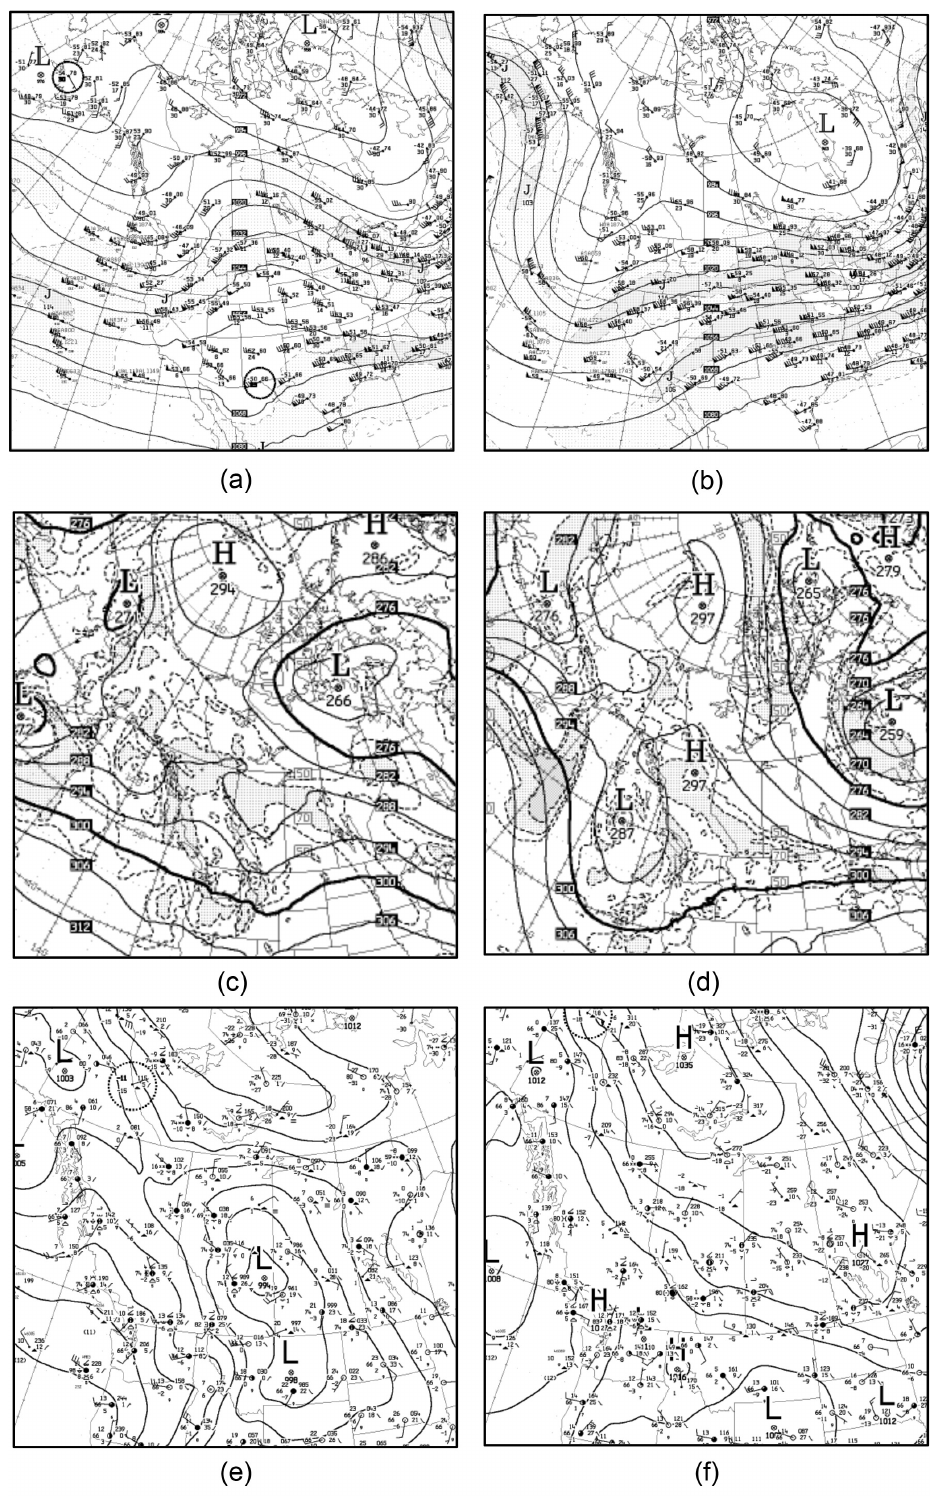
Figure 3. (a) and (b) are the 250hPa analyses of the geopotential heights and wind fields. (c) and (d) are the analysis at 700hPa that includes relative humidity. The shaded area is relative humidity of > 70% and (e) and (f) are the sea-level pressure indicated by the location of the surface weather systems. (a) , (c) and (e) are at 00:00UTC 1 April 2015, which corresponds to a westerly flow event and (b) , (d) and (f) are at 00:00UTC 5 April 2015, which corresponds to a easterly flow event (sources: Environment and Climate Change